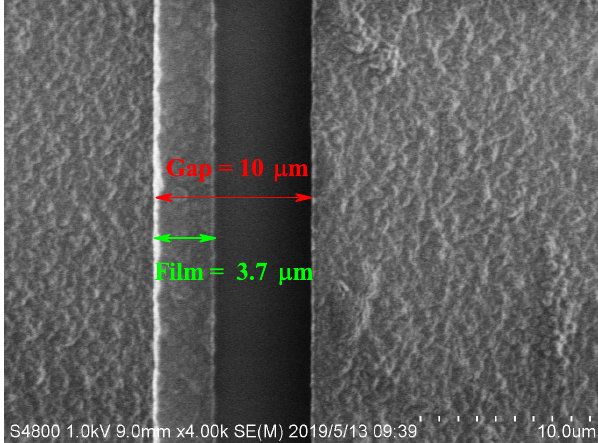
Figure 5. (Color online) SEM images of the surface ion trap with adsorbed atoms. The gap width of the two electrodes is approximately 10 µ m covering a Ca atomic film with a 3.7 µ m